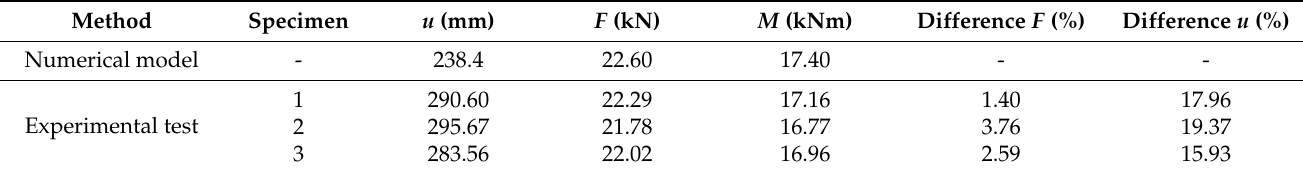
Table 10. Results of Experiment A (bolts and dowels).